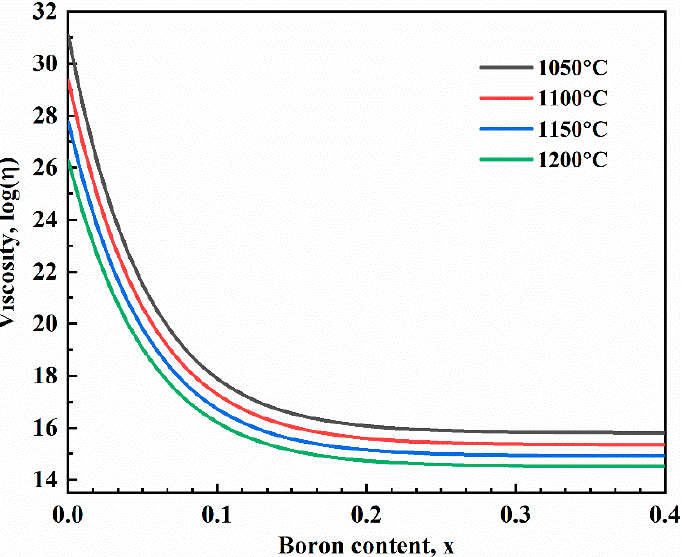
Figure 3. The viscosity of borosilicate glass as a function of boron content.